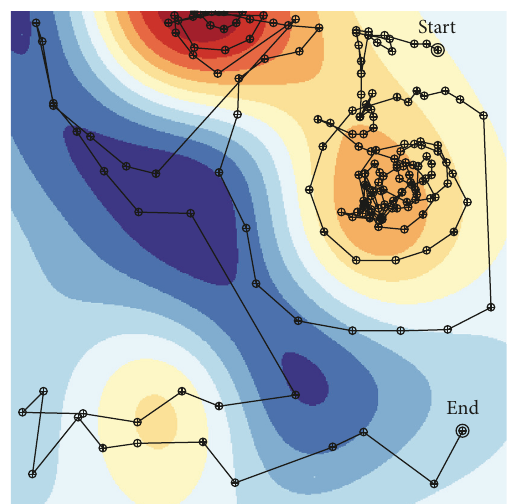
Figure 10: Example of an UAV path when adopting the PdUC mobility model.